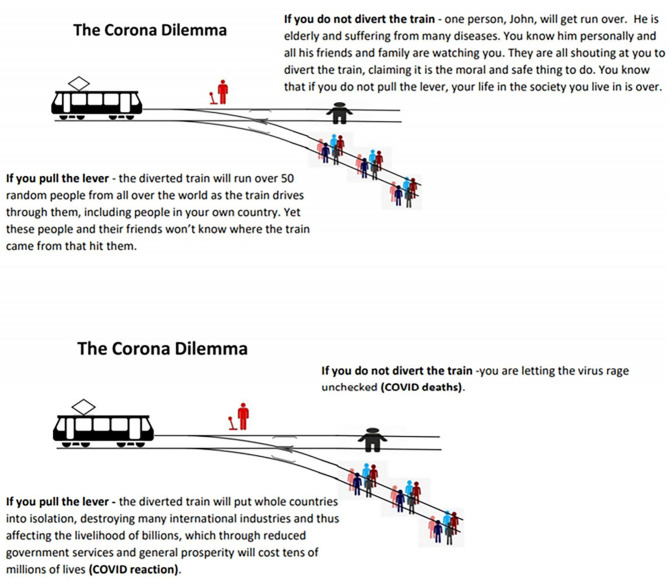
(A) The Trolley Dilemma using numbers compatible with the Corona Dilemma. Modified with permission from Frijters (144). (B) The Corona Dilemma choices explicitly explained. Modified with permission from Frijters (144).